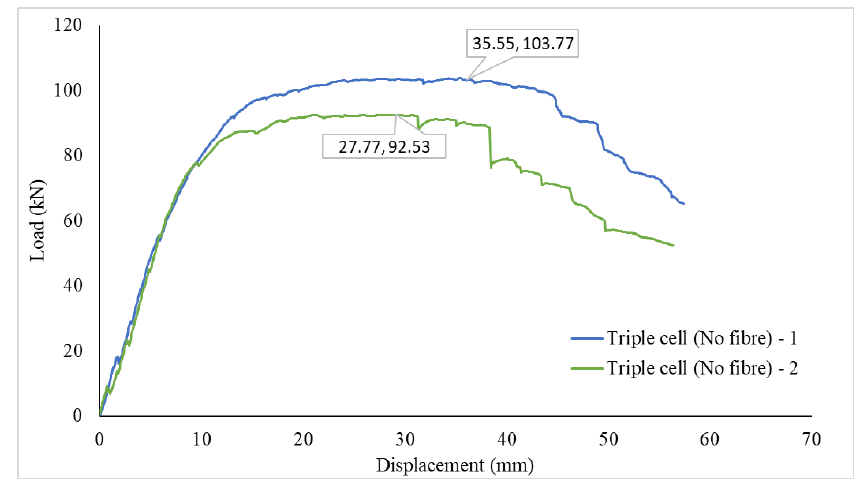
Figure 7. Load vs. displacement of triple-cell infill panels. Table 5. Results from triple-cell infill panels.